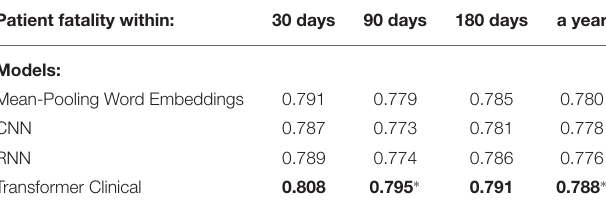
TABLE 7 | Comparison of the deep neural models on on a randomly chosen 512-token sub-sequence of discharge summaries for patient fatality prediction targets.